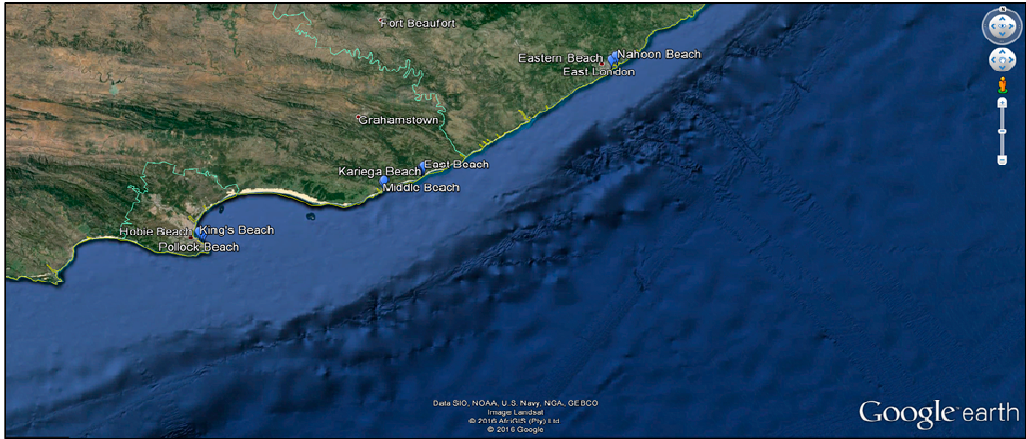
Figure 1. Aerial view of sampling sites [32].